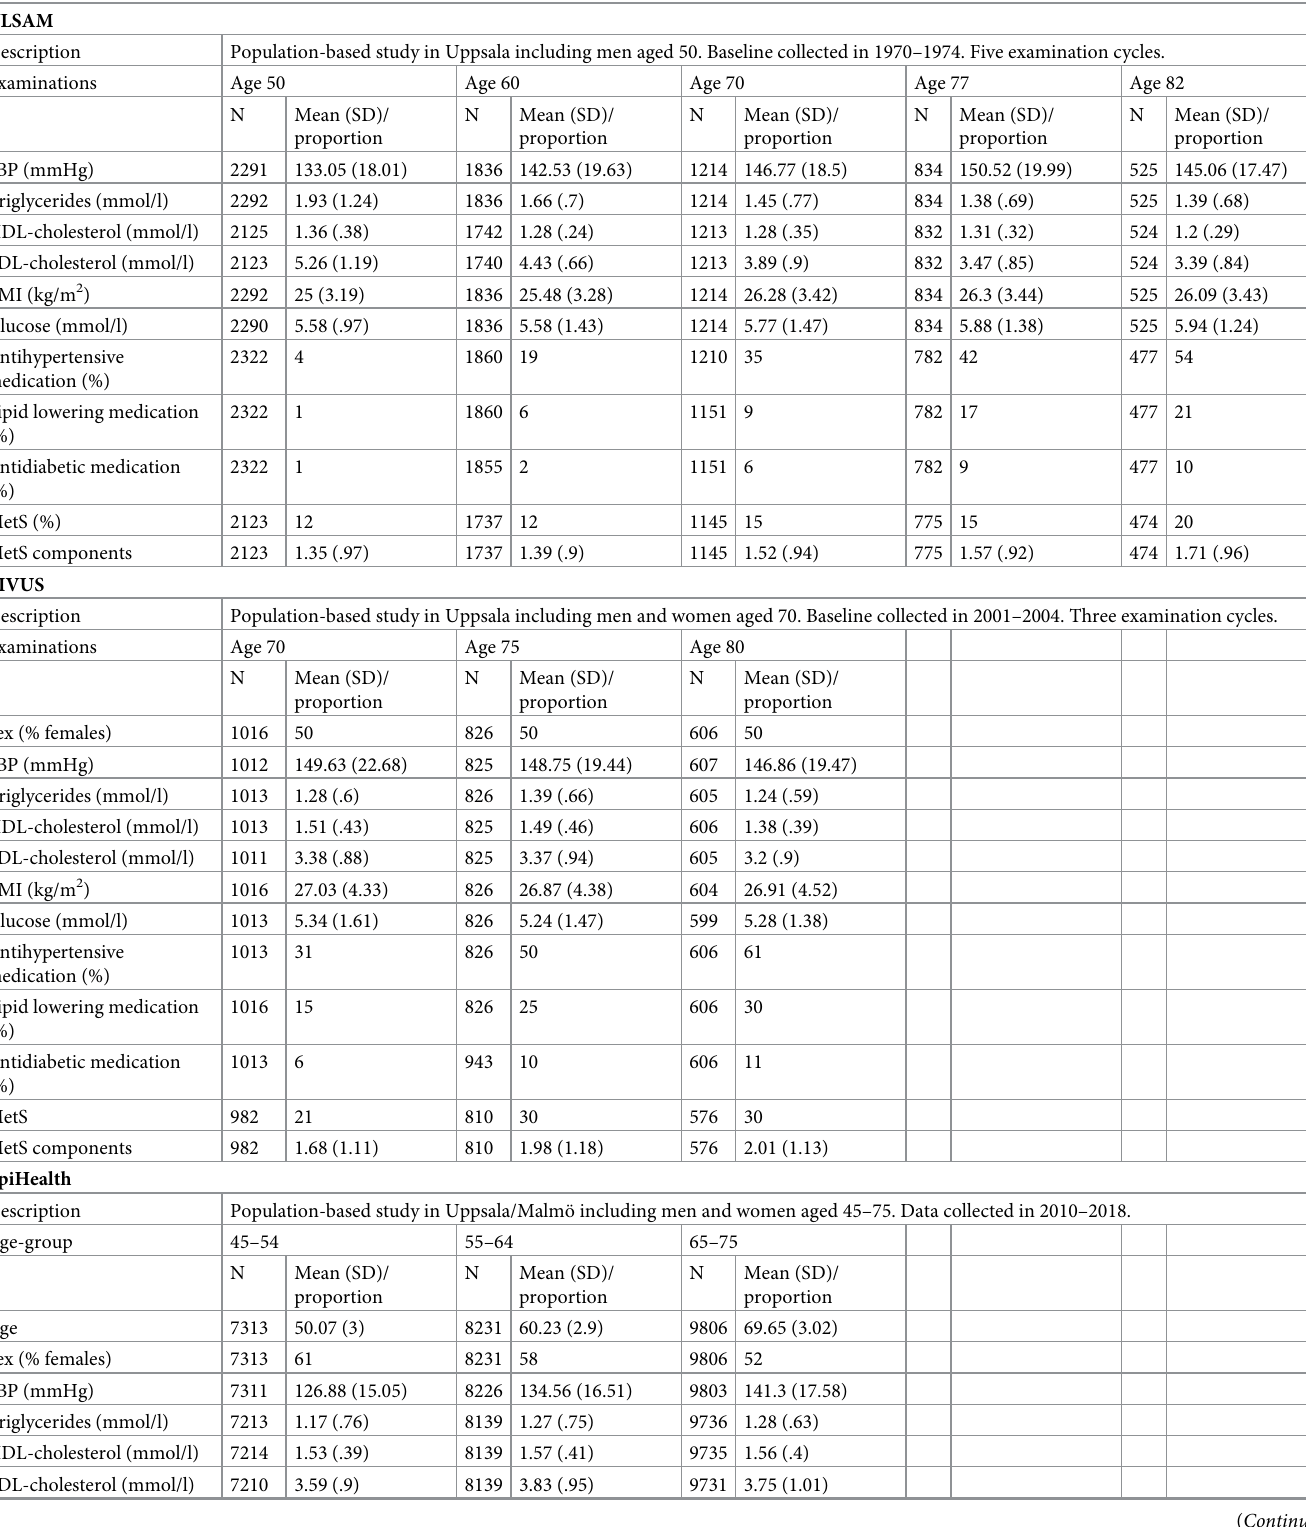
Table 1. Description of studied variables in the different